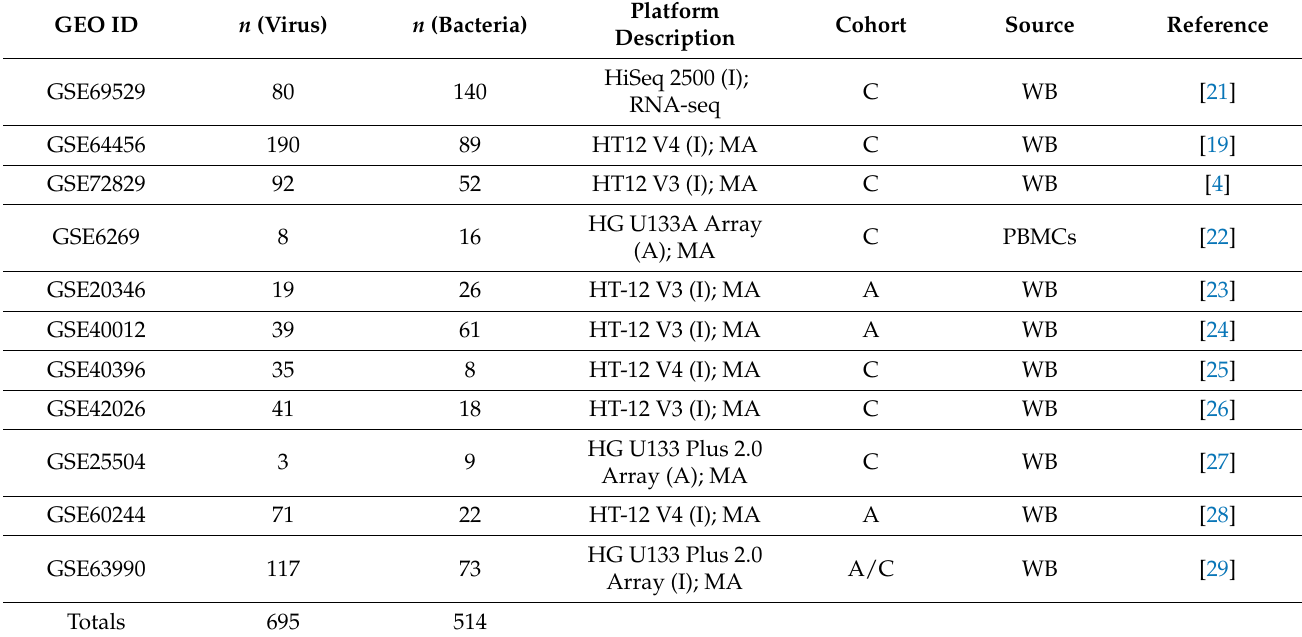
Table 1. Samples included in the meta-analysis (GEO: Gene Expression Omnibus). Platform: lllumina (I), Affymetrix (A); MA: microarray; Cohort: children (C); Adult (A); Source: whole blood (WB), peripheral blood mononuclear cell